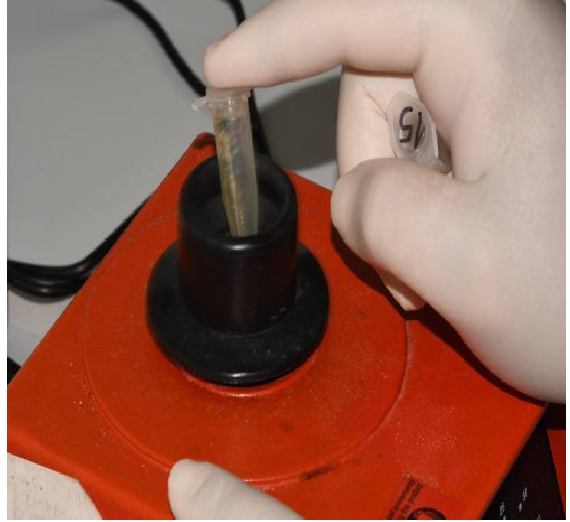
Figure 7. Vortexing. Figure 7.